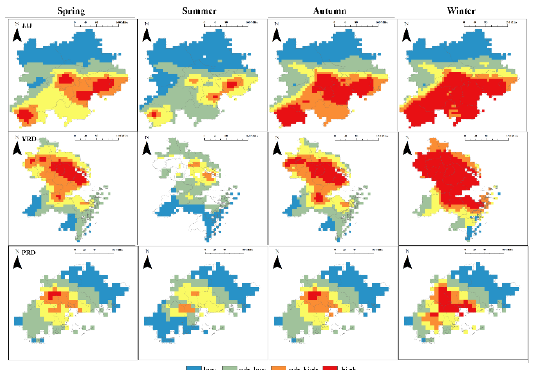
Figure 2. The spatial distribution of seasonal HPC in the JJJ, YRD and PRD